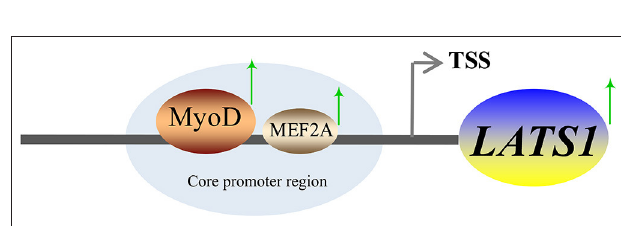
FIGURE 8 | A proposed schematic summary of the regulation of LATS 1 expression by Myod1 and MEF2A transcription factors